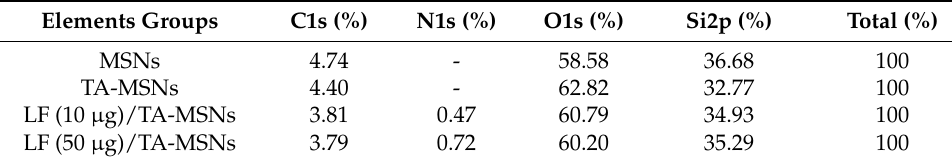
Table 1. Elemental compositions of bare and modified MSNs by XPS analysis.